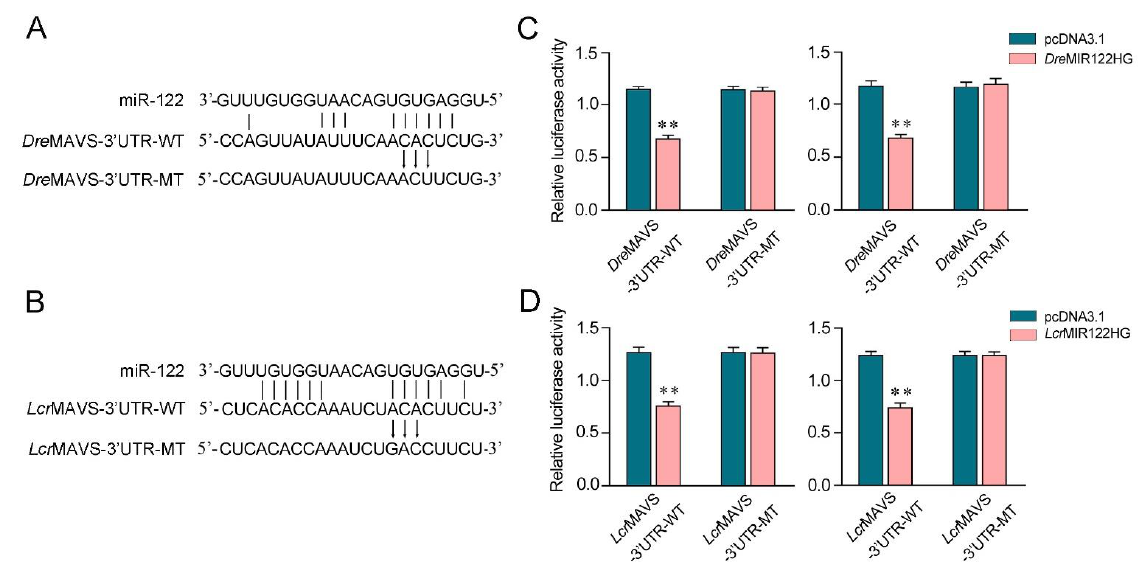
Figure 6. MIR122HG-regulating MAVS gene is widely found in fish. ( A , B ) Schematic diagram of the predicted target sites of miR-122 in the 3 ′ -UTR of D. rerio MAVS ( A ) and L. crocea MAVS ( B ). ( C ) EPC cells (left panel) and HEK293 cells (right panel) were cotransfected with Dre MIR122HG or pcDNA3.1, together with the wild-type Dre MAVS- 3′UTR (WT) or the mutant -type Dre MAVS- 3′UTR (MT) for 24 h, and then the luciferase activity was measured. ( D ) EPC cells (left panel) and HEK293 cells (right panel) were cotransfected with Lcr MIR122HG or pcDNA3.1, together with the wild-type Lcr MAVS- 3′UTR (WT) or the mutant -type Lcr MAVS- 3′UTR (MT) for 24 h, and then the luciferase